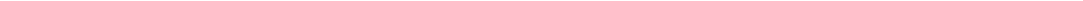
Fig. 7 Conditional ablation of Runx1 in NKT. a Intracellular fl ow cytometry for Runx1 expression in thymic CD4SP and NKT cells. (LM controls (LM), solid histogram; Cd4 - Cre Runx1 fl /+ (Het), dashed histogram; Cd4 - Cre Runx1 fl / fl (KO), gray shaded .) b NKT cells in the thymus of Het and KO compared to their LM. The frequency and absolute cell number of NKT are summarized on the right panels . Data are representative of fi ve to eight mice from four independent experiments. c Individual thymus of indicated strains were MACS-enriched using CD1d- α GalCer tetramers before FACS analysis of NKT developmental subsets and PLZF expression. Data are summarized from four independent experiments, with 4 – 12 mice in each group. d Rescue of NKT defect in Het by PLZF transgene expression. Data are representative of four to 11 mice from three independent experiments. e Representative FACS analysis of IL-7R α and IL-2R β expression in stage 1 NKT thymocytes from LM and KO; mean ± S.E.M. of mean fl uorescence intensity (MFI) is 5535 ± 331 ( n = 4) vs 1501 ± 40 ( n = 3) for IL-7R α ; and 5721 ± 87 ( n = 4) vs 3040 ± 163 ( n = 3) for IL-2R β , respectively. Leftmost histogram represents unstained control. f Runx1 ChIP-seq tracks at the Il7ra and Il2rb loci. g FACS analysis of Egr2 expression in CD4 SP, stage 0 and stage 1 NKT thymocytes from LM, Het and KO. Mean ± S.E.M. of Egr2 MFI: 2090 ± 84 (LM, n = 5), 1927 ± 45 (Het, n = 4) and 1506 ± 18 (KO, n = 6) in CD4 SP; 9688 ± 461 (LM, n = 5), 8872 ± 389 (Het, n = 4) and 5722 ± 316 (KO, n = 6) in stage 0 NKT; 4174 ± 287 (LM, n = 5), 4310 ± 257 (Het, n = 4), and 3892 ± 216 (KO, n = 6) in stage 1 NKT. h Runx1 ChIP-seq track at the Egr2 locus. Statistical analysis was performed using one-way ANOVA with multiple comparisons. * P < 0.05, ** P < 0.01, *** P < 0.001, **** P <